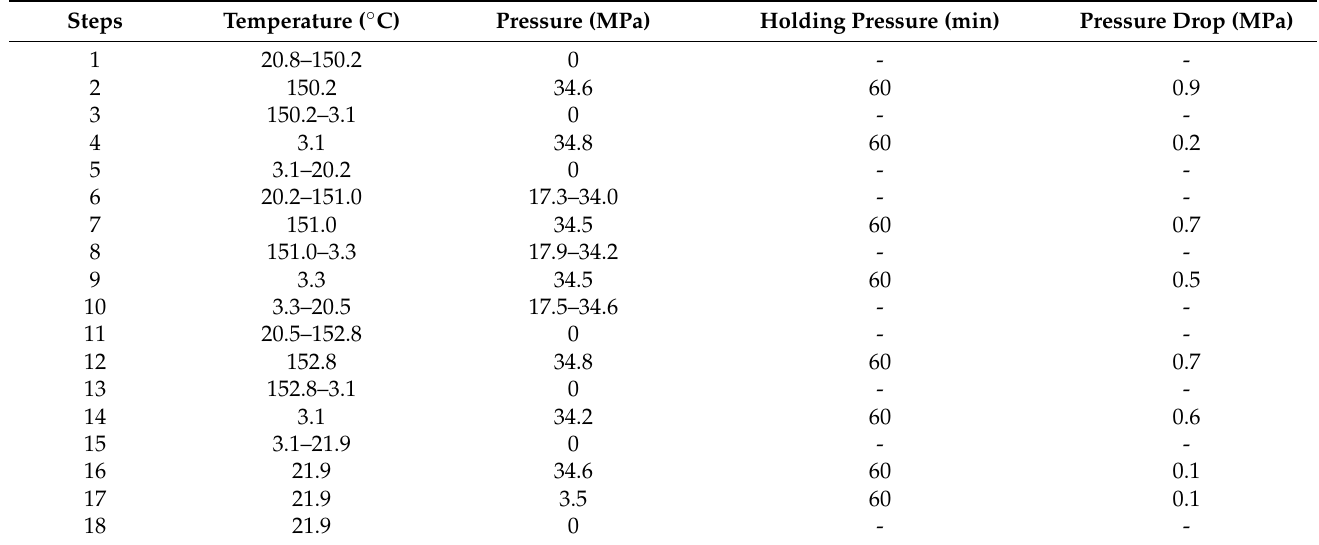
Table 7. Holding-pressure data of the temperature cycle